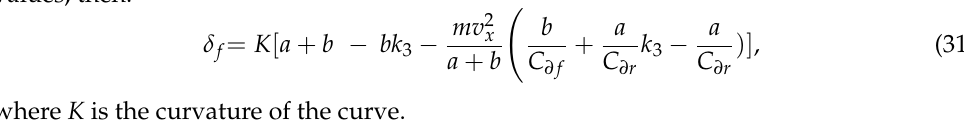
Table 1. Vehicle model parameters.